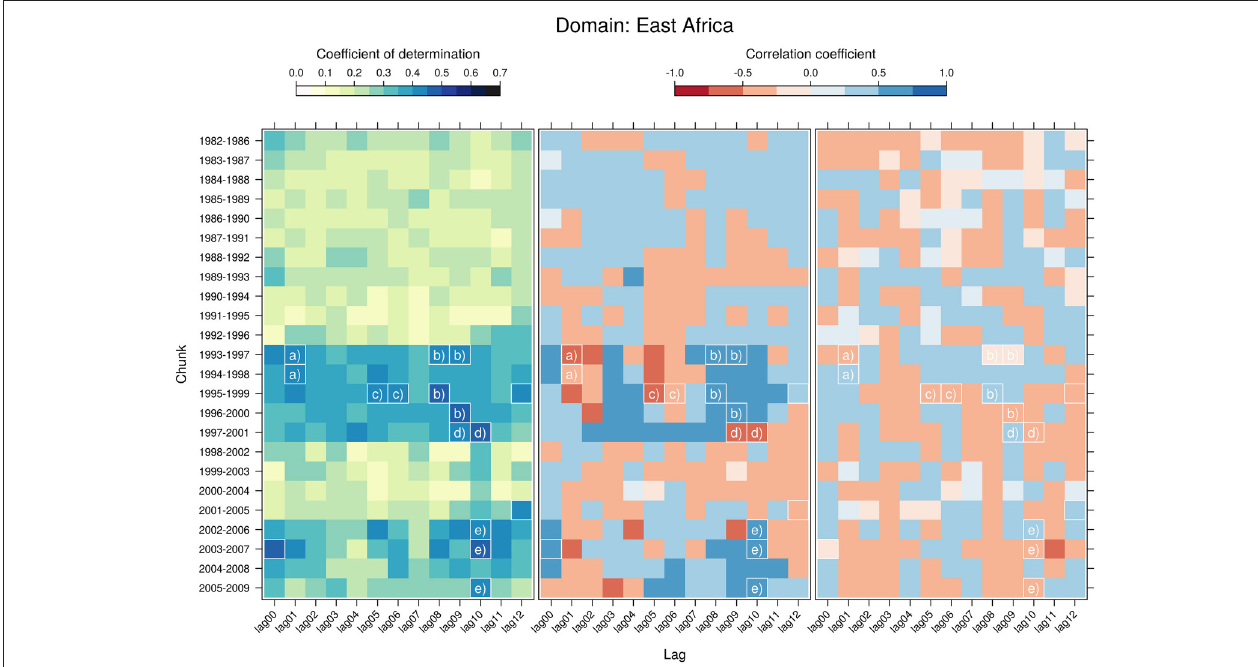
FIGURE 2 | Left: Explained space-time variance of the East African response domain for modes 1 and 2 by chunk and lag. Center: Mean correlation coefficient between the identified base point and all pixels in the response domain by chunk and lag for mode 1. Right: Mean correlation coefficient between the identified base point and all pixels in the response domain by chunk and lag for mode 2. Labels a–e show the chunk/lag combinations that are used in Figure 3 . Solid white squares denote upper 0.95 quantile in explained variance.